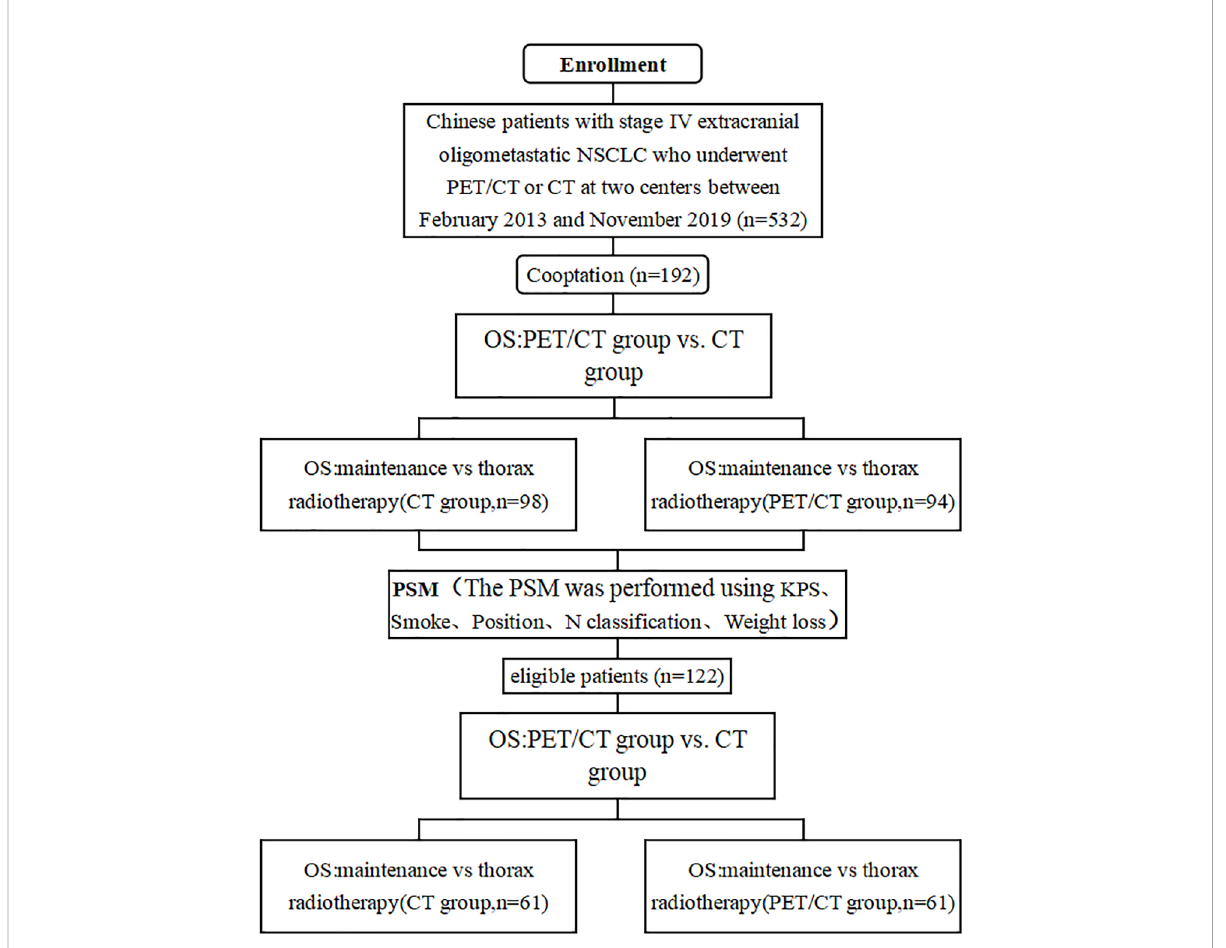
FIGURE 1 Flowchart depicting selection of the study